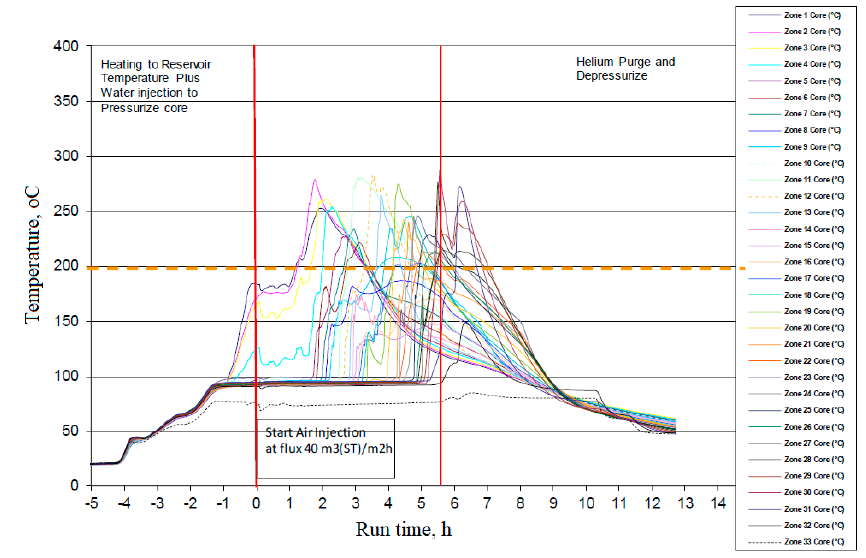
Figure 7. Reverse Combustion Test Temperature Profiles (Color should be used).